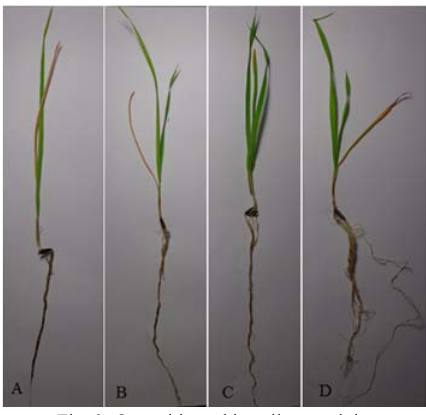
Fig. 3: Oat cultivated in soils containing A) Control, B) Ag + _bentonite, C) Ag + _phosphate and D) AgNp_silica